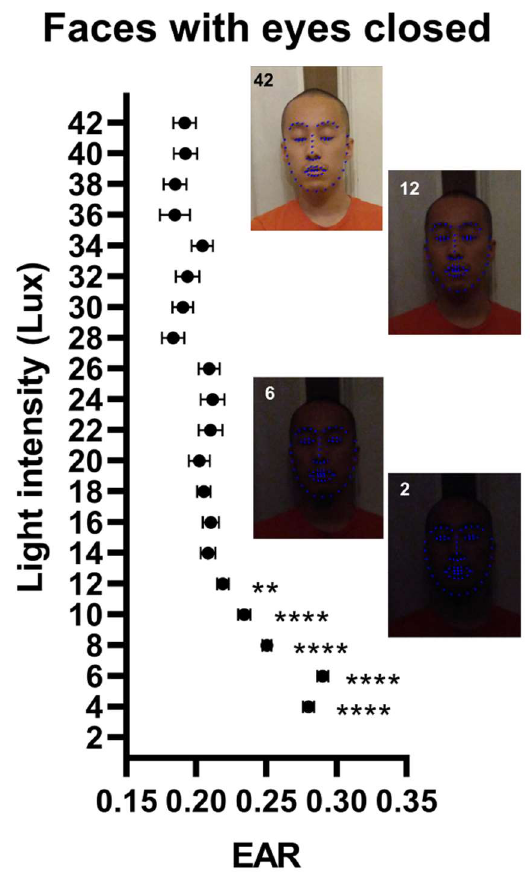
Figure 3. Palpebral fissure dimension and model performance as a function of image resolution and light intensity. Data points are the eye aspect ratio (EAR) estimates as a function of image lighting in faces with eyes closed. Inserts show images at different lighting levels with overlaying model prediction. Data points ± error represent mean value ± SEM. Statistical significance levels were for one-way ANOVA with multiple comparisons using images of the best quality as the comparator. EAR: Eye aspect ratio. **: p < 0.01; ****: p < 0.0001.